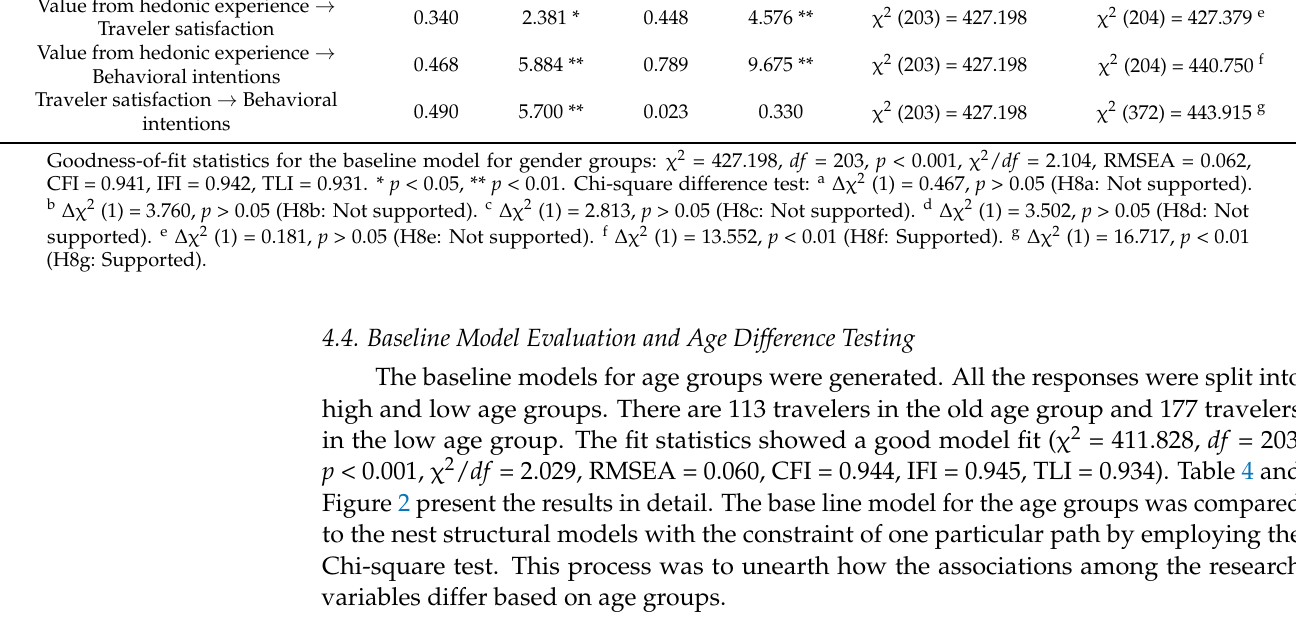
Table 4. The invariance model assessment for age